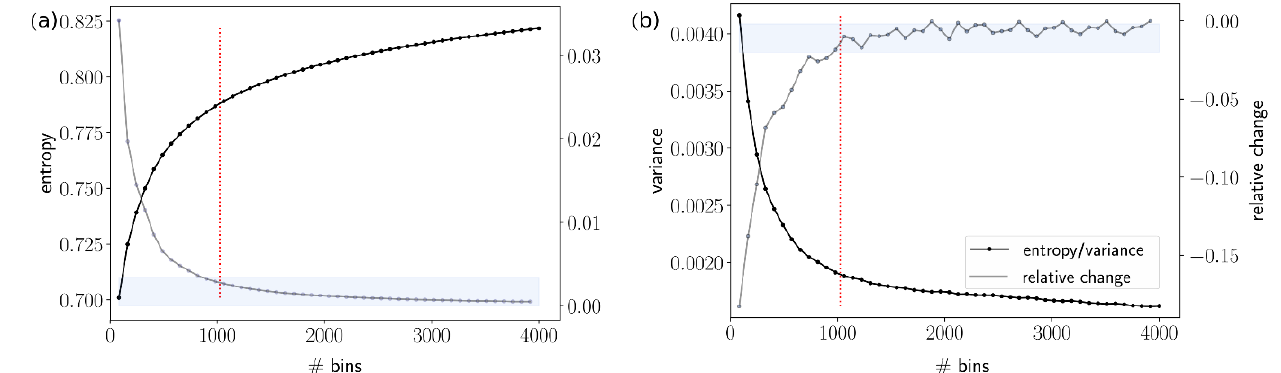
Figure 2. Spectral entropy ( a ) and intra-bin variance ( b ) for 50 different bin counts, averaged over 16,000 recordings (black line). The grey line displays the relative change of subsequent values to each other, and the blue shaded area indicates where this value is below 10% of its maximum change.